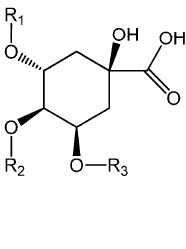
Figure 4. Chemical structures of phenolic acids and their derivatives in H. diffusa.